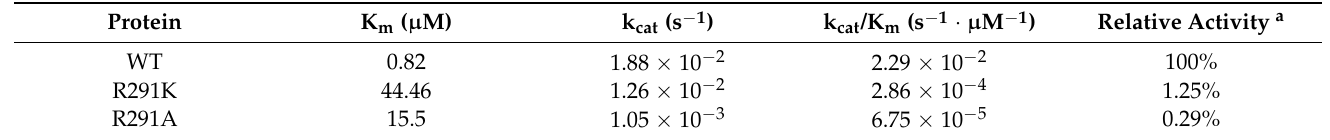
Table 2. Kinetic parameters for dNTP insertion by WT Hs PrimPol and Arg 291 mutants.